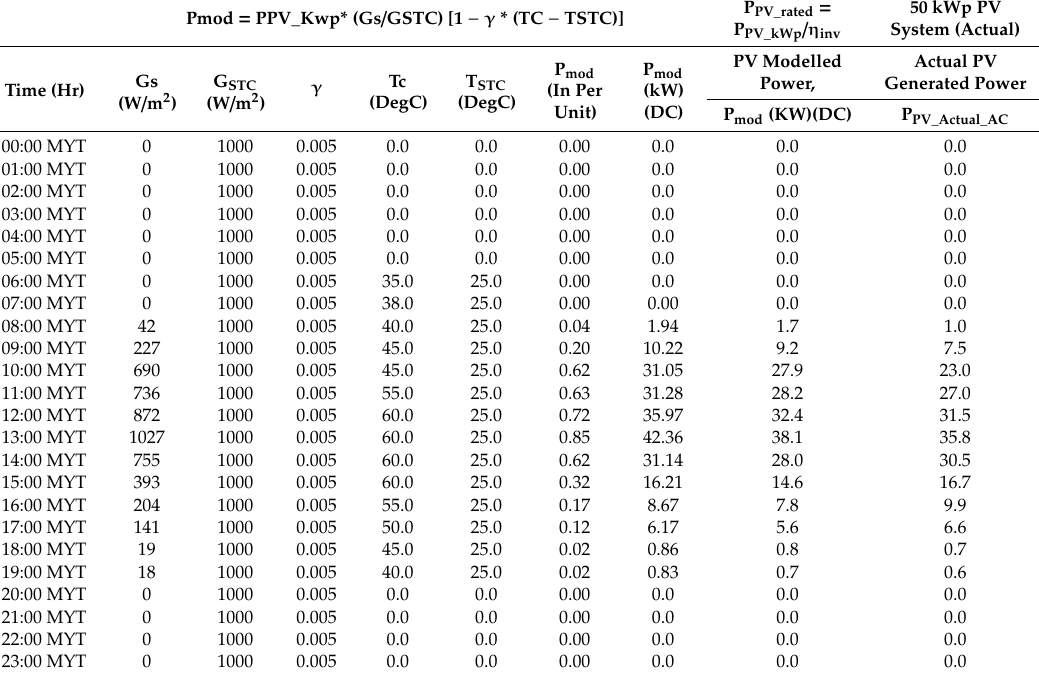
Table 10. MDRed model validation data with solar PV-battery system.